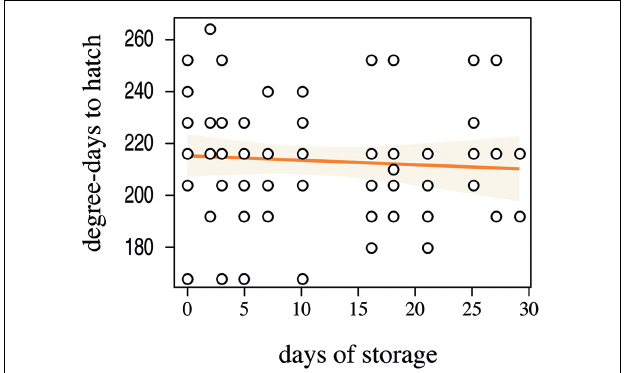
FIGURE 4 | Logistic regression between the days of storage at 6 ◦ C and the probability of Heteronychus arator eggs to hatch. Open circles indicate the observed data, closed circles indicate the number of hatched or non-hatched egg (in a shade of gray where white = 0% and black = 100% hatching). The light orange zone represents the 95% confidence interval of the fitted model (orange solid line).